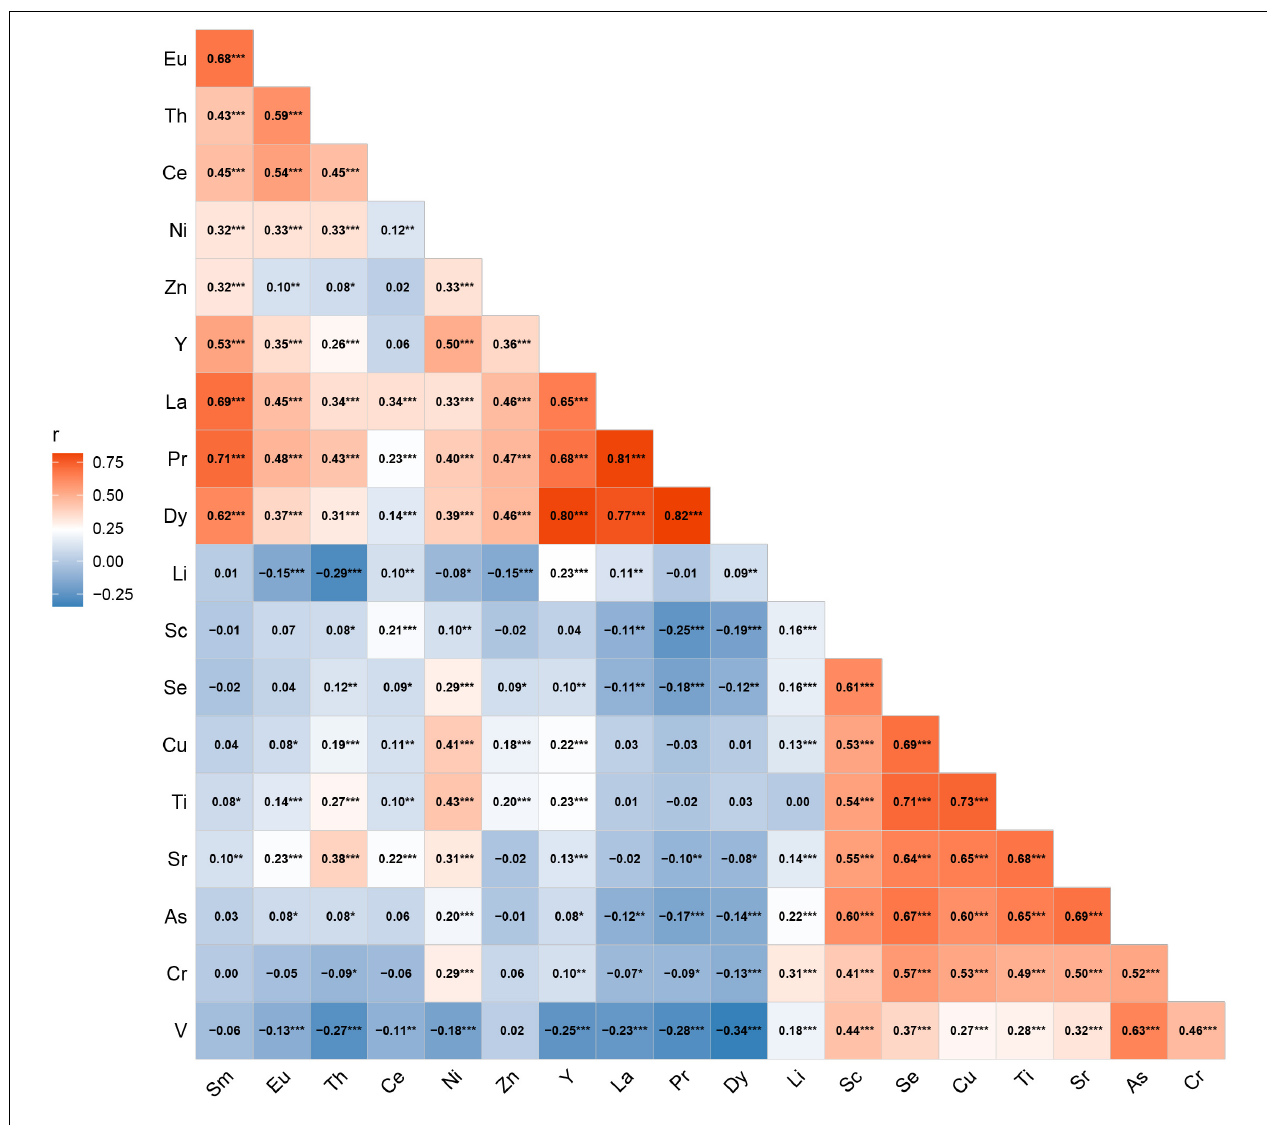
FIGURE 1 | Spearman correlations between serum metals. *** P < 0.001; ** P < 0.01; * P <